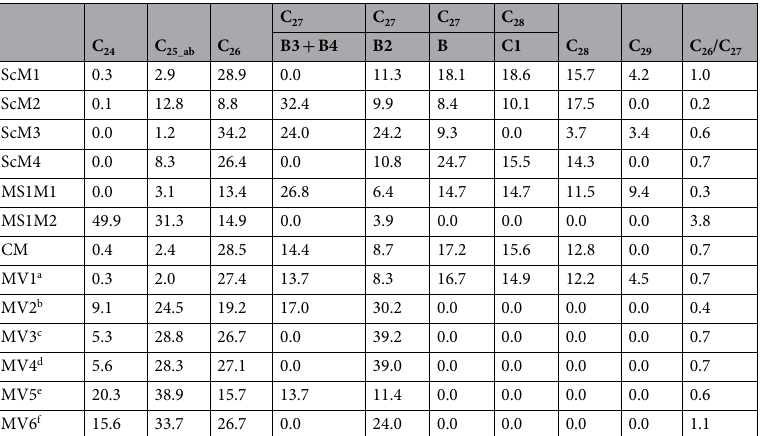
Table 1. Relative percentages of the main chromophores isolated from different mauveine samples at λ = 550 nm, including the ratio between the sum of all C 26 (mauveine A) and all C 27 (mauveines B, B2, B3 and B4) compound percentages. a 1:2:1; b 1:4:1, c 1:4:2, d 0:1:0, e 1:10:5 and f 1:10:10 mole ratio of aniline, p -toluidine and o- toluidine